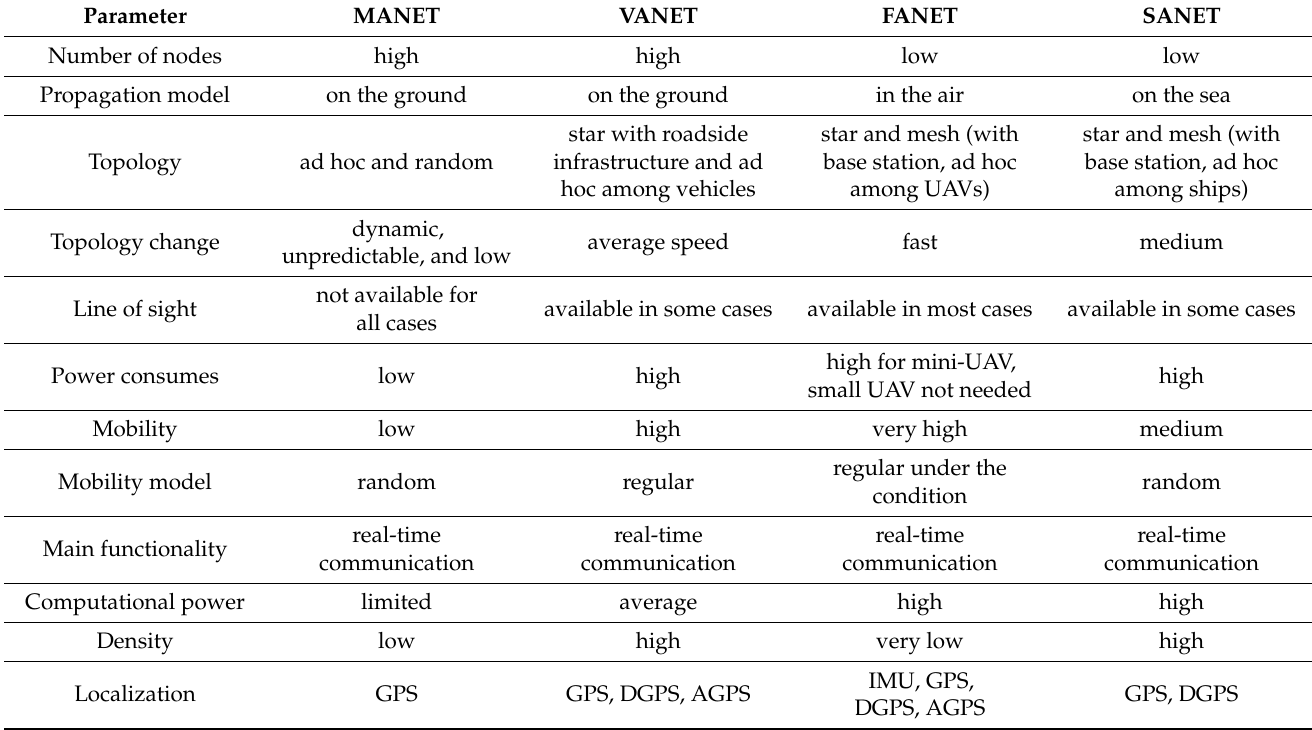
Table 2. Comparison of ad hoc